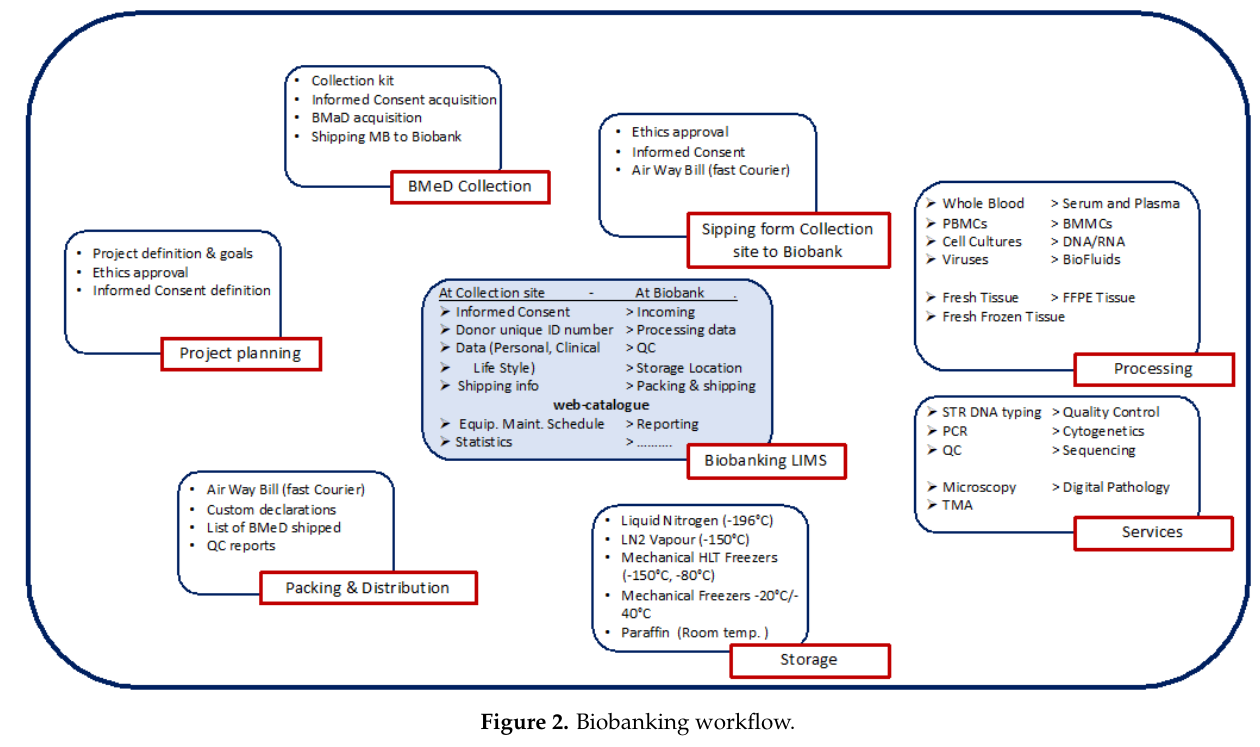
Figure 2. Biobanking workflow.